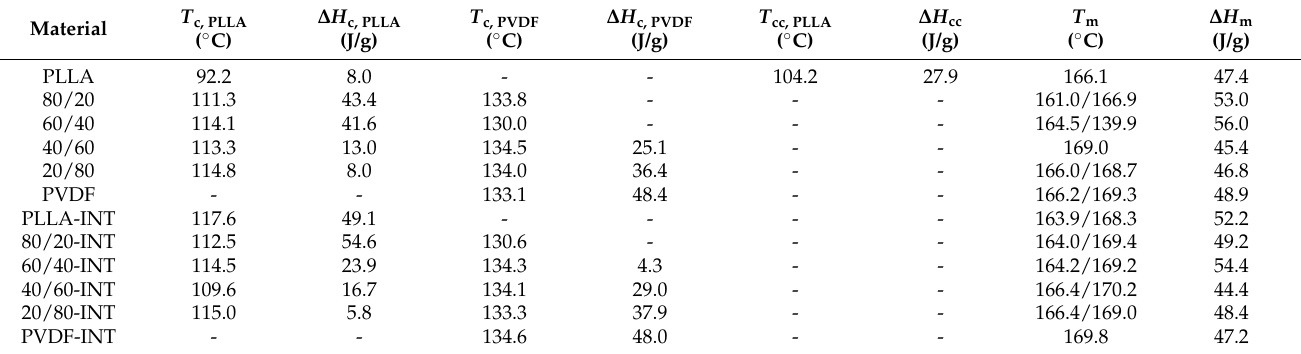
Figure 7. ( a ) Variation of the crystallization temperature ( T c ) and ( b ) crystallization enthalpy ( ∆ H c ) of PLLA and PVDF in the binary PLLA/PVDF and ternary PLLA/PVDF/INT-WS 2 hybrid nanocom- posites with composition. Table 2. DSC parameters of different PLLA/PVDF/INT-WS 2 blend nanocomposites based on PLLA, PVDF, and INT-WS 2 . T c,PLLA Material ( ◦ C)